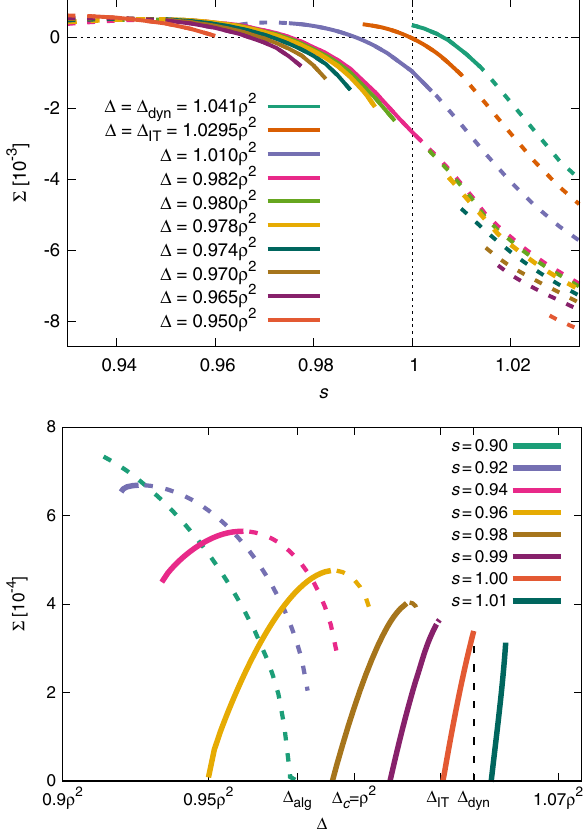
FIG. 2. The complexity of metastable states Σ as a function of the Parisi parameter s and the noise Δ , for prior (2) with sparsity ρ ¼ 0 . 08 . Upper: Complexity at fixed s in the whole domain of existence of a nontrivial fixed point. Lower: The physical region of positive Σ as a function of Δ . We draw the stable solutions with a solid line and the unstable, with respect to the eigenvalues (28), ; Δ with a dashed line. For each value of Δ ∈ ½ Δ , the value of IT dyn (cid:2) Σ ð Δ ; s ¼ 1 Þ represents the complexity of the family of thermo- dynamically dominating states. Below Δ , the s ¼ 1 solution is IT nonphysical and Σ ð Δ ; s ¼ 1 Þ < 0 . The algorithmic threshold of AMP occurs when the ghost-glassy states at s ¼ 1 have a spinodal transition towards the